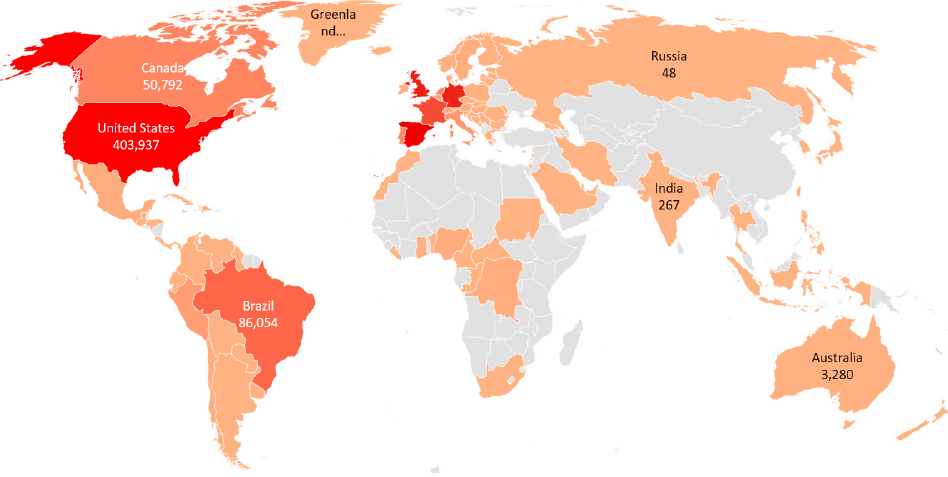
Figure 1. New and cumulative cases of monkeypox worldwide from May through 28 August 2022.